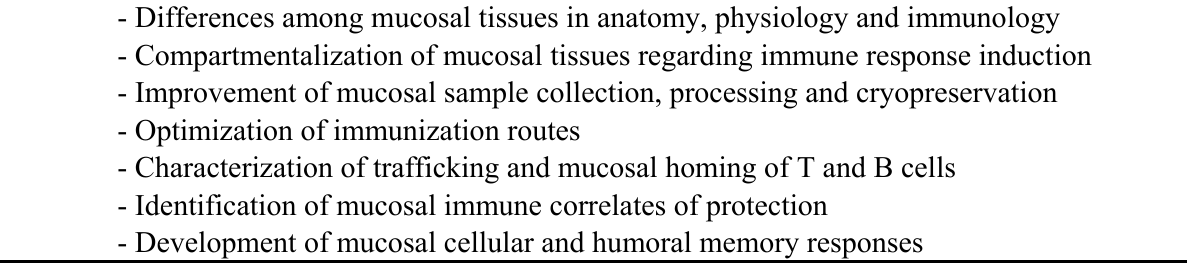
Table 1. Key issues in SIV/HIV mucosal vaccine